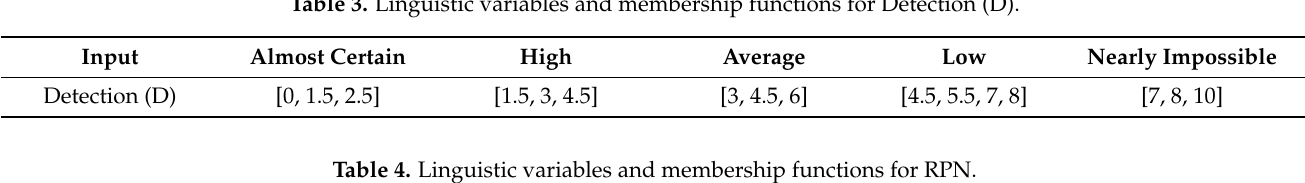
Table 3. Linguistic variables and membership functions for Detection (D).